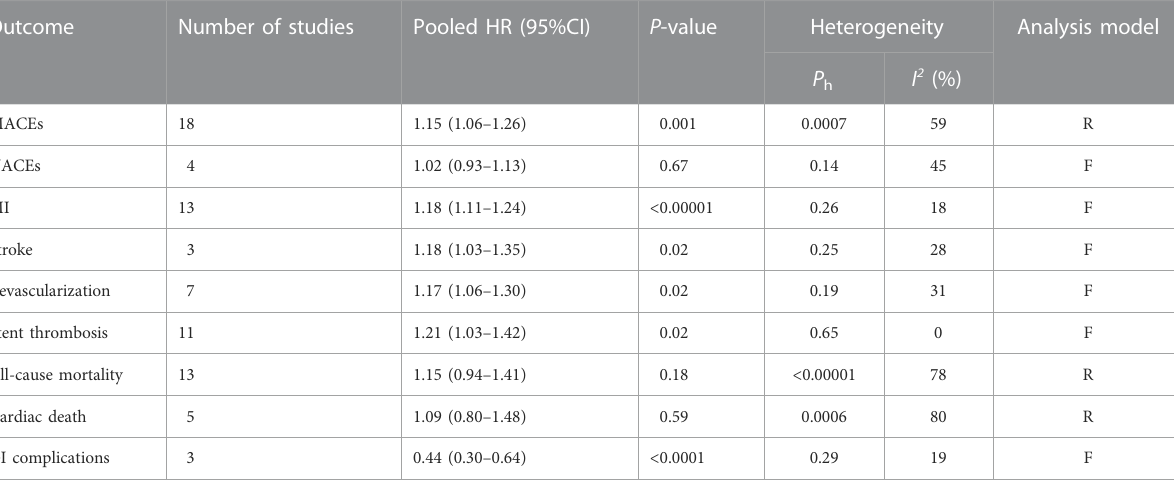
TABLE 3 Meta-analysis on